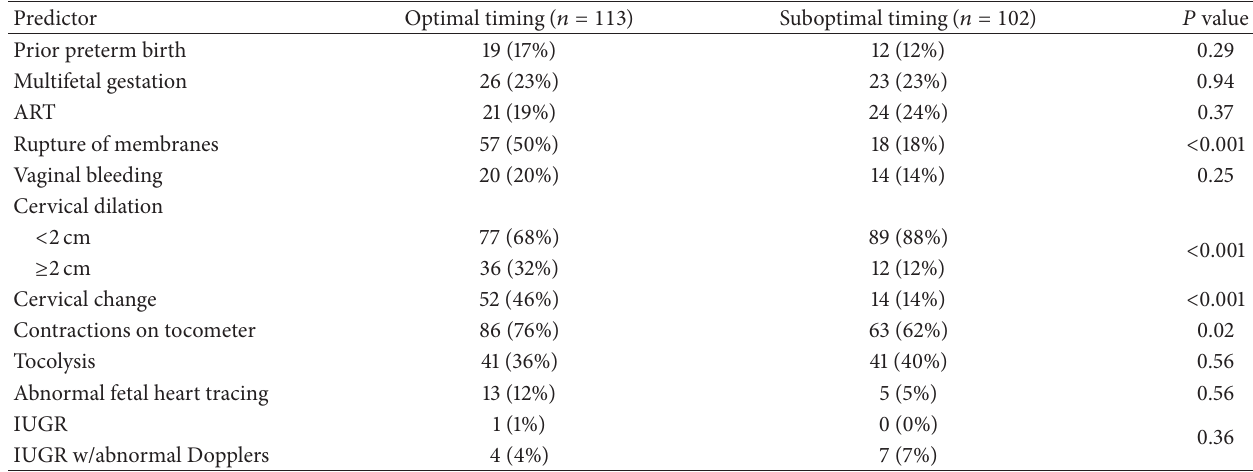
Table 2: Predictors of optimal timing of antenatal